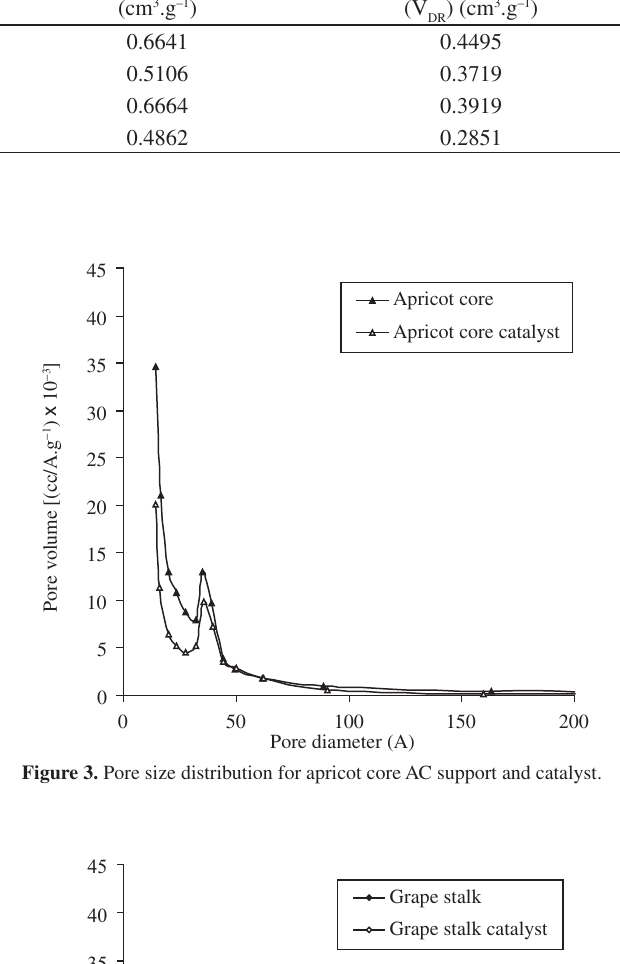
Table 1. Textural parameters. Sample